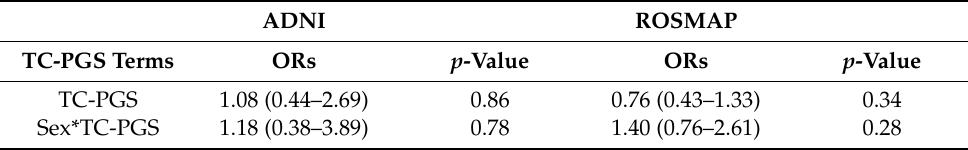
Table 3. TC-PGS effect on cognitive impairment.